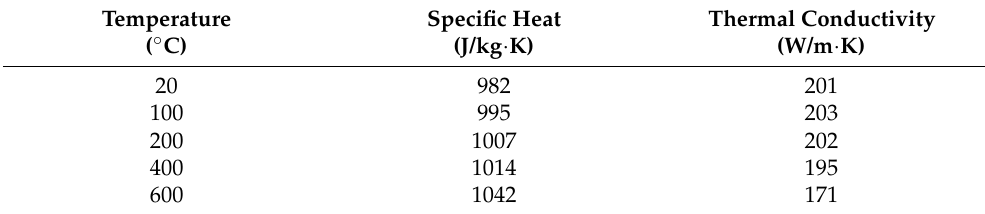
Table 2. Temperature-dependent properties of the Al–Mg–Si alloy